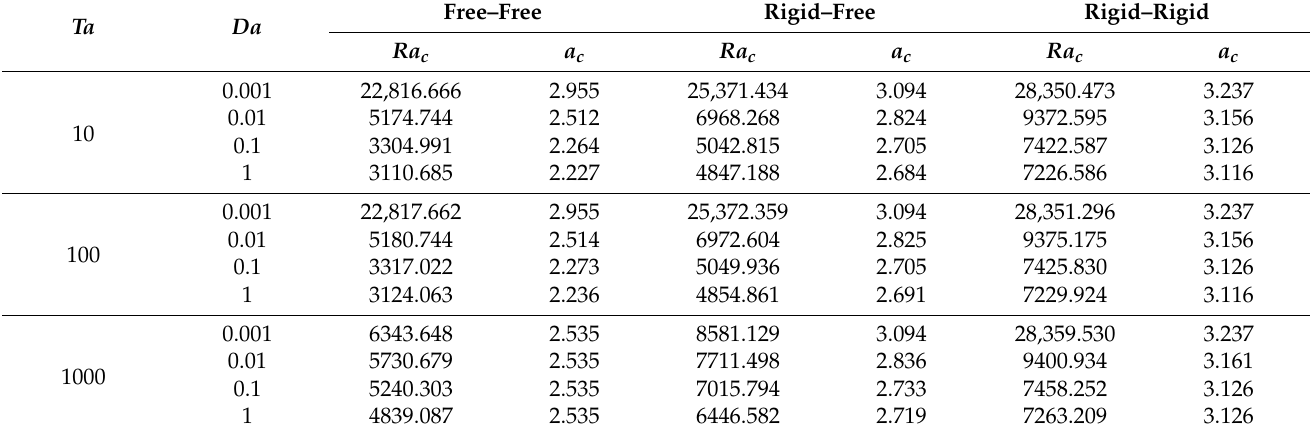
Table 7. Critical values of Ra and a for Sr = 0.2, Du = 0.02, Rs = 200, Le = 5, Λ = 8, M = 0.9, φ =